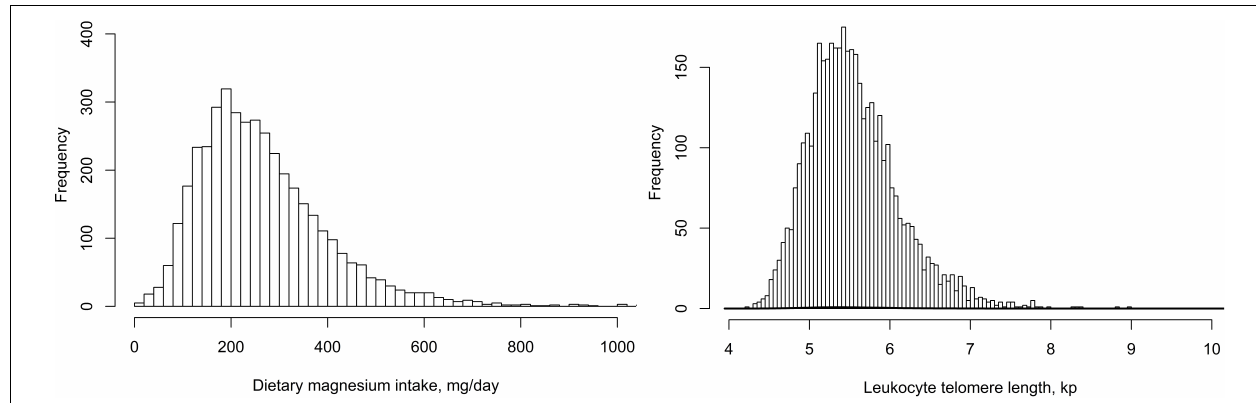
Hispanic, or other), education (less than high school, high school, or greater than high school), smoking (never smoker, former smoker, or current smoker), physical activity (sedentary, low, moderate, or high), hypertension, and self-reported history of diabetes. Hypertension was defined as having a history of hypertension, a systolic blood pressure ≥ 140 mmHg and/or diastolic blood pressure ≥ 90 mmHg, and using antihypertensive medications (12, 27).